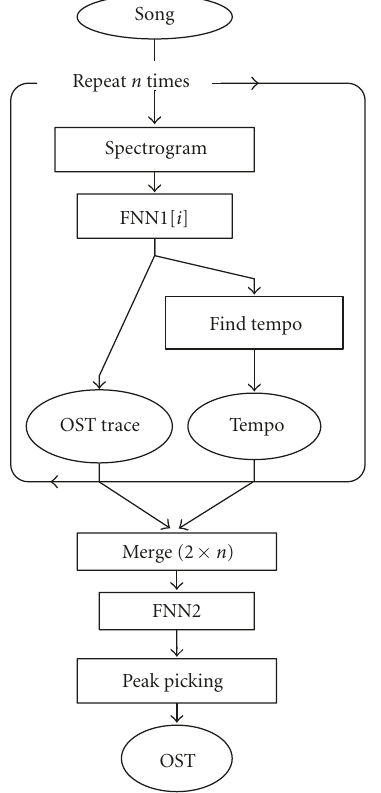
Figure 3: MULTI-NET flowchart. The SINGLE-NET variant is re- peated multiple times with di ff erent hyperparameters. A tempo- detection algorithm is run on each of the resulting feed-forward neural network (FNN) outputs. The SINGLE-NET outputs and the tempo-detection outputs are then combined using a second neural